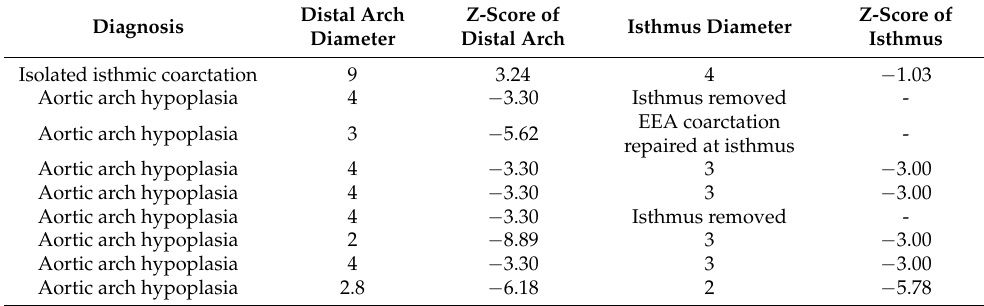
Table 1. Diameter and z-scores of the distal arch and isthmus for 9 specimens with aortic arch narrowing. The 1 case of aortic arch interruption was excluded. In 2 hearts, the isthmus had been removed, and in 1, it had been repaired, so no z-score was calculated. Distal Arch Z-Score of Z-Score of Diagnosis Isthmus Diameter Diameter Distal Arch Isthmus Isolated isthmic